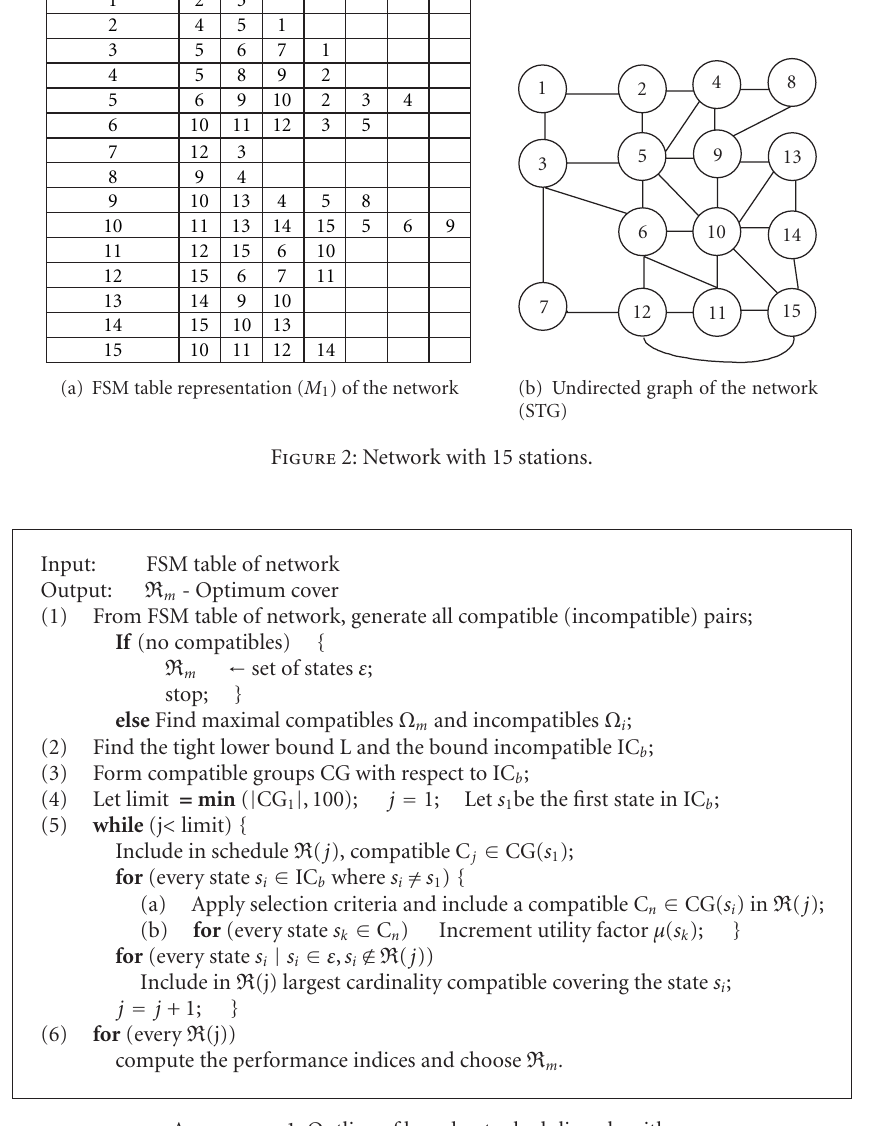
Algorithm 1: Outline of broadcast scheduling